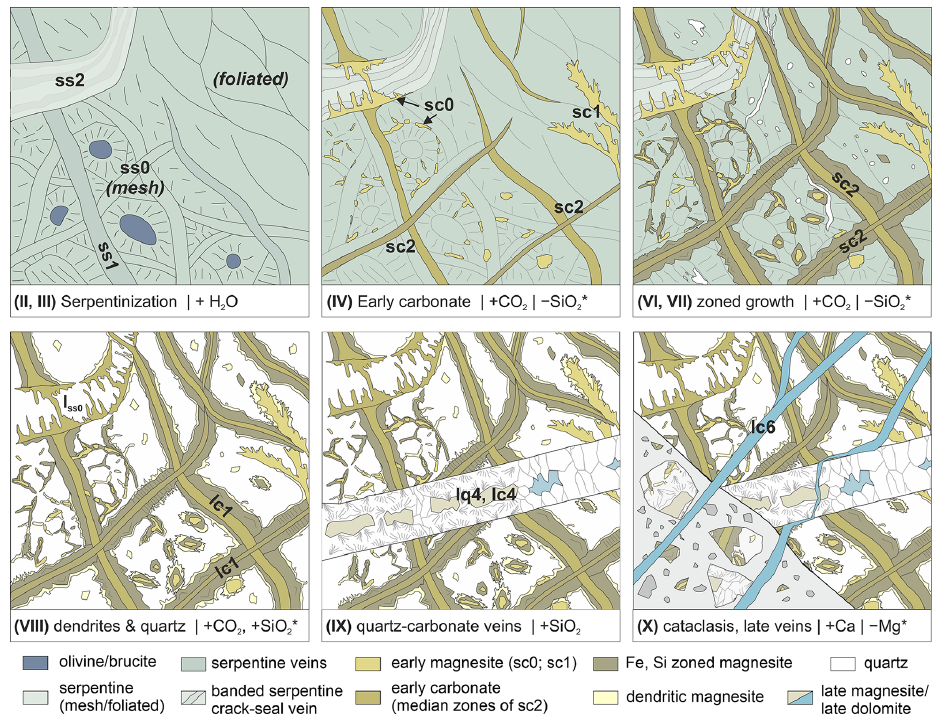
Figure 10. Sketch of the evolution of carbonation and vein formation in Hole BT1B, as inferred from serpentinite and listvenite samples (different stages, see text). Different stages were related to differing element transfer with gains (denoted by, e.g., + H 2 O); inferred losses (e.g., − SiO 2 *) are likely only relevant on a local scale. For clarity, not all vein generations (see Tables 1 and 2) are